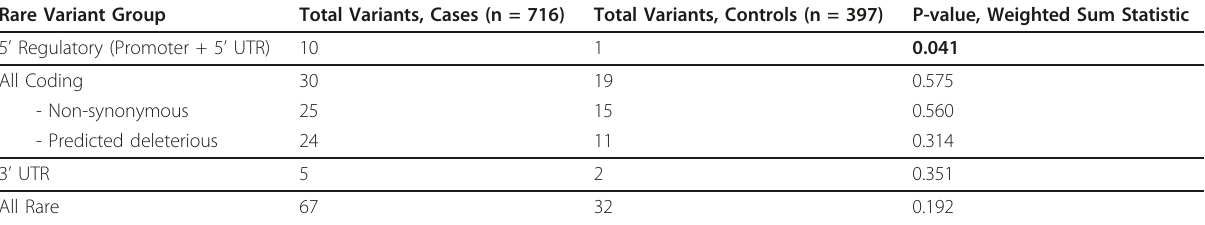
Table 4 Groupwise association testing of ZNF750 functional groups with psoriasis Rare Variant